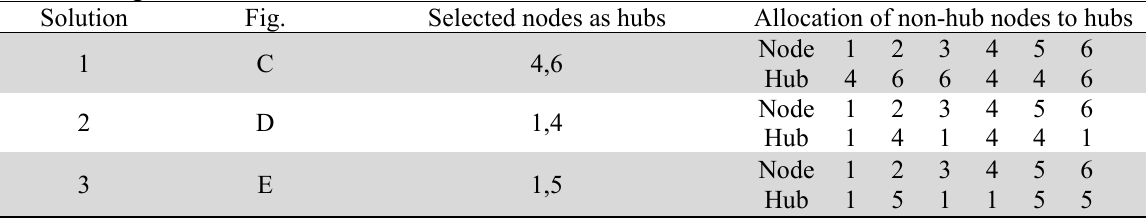
How to assign non-hub nodes to different hubs in efficient solutions Solution Fig. Selected nodes as hubs